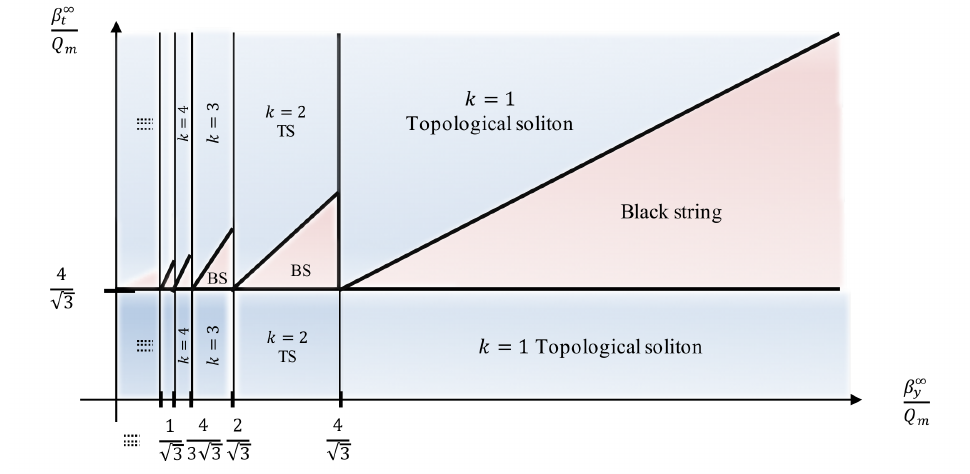
Figure 4 . The globally-stable phases between the black string and topological